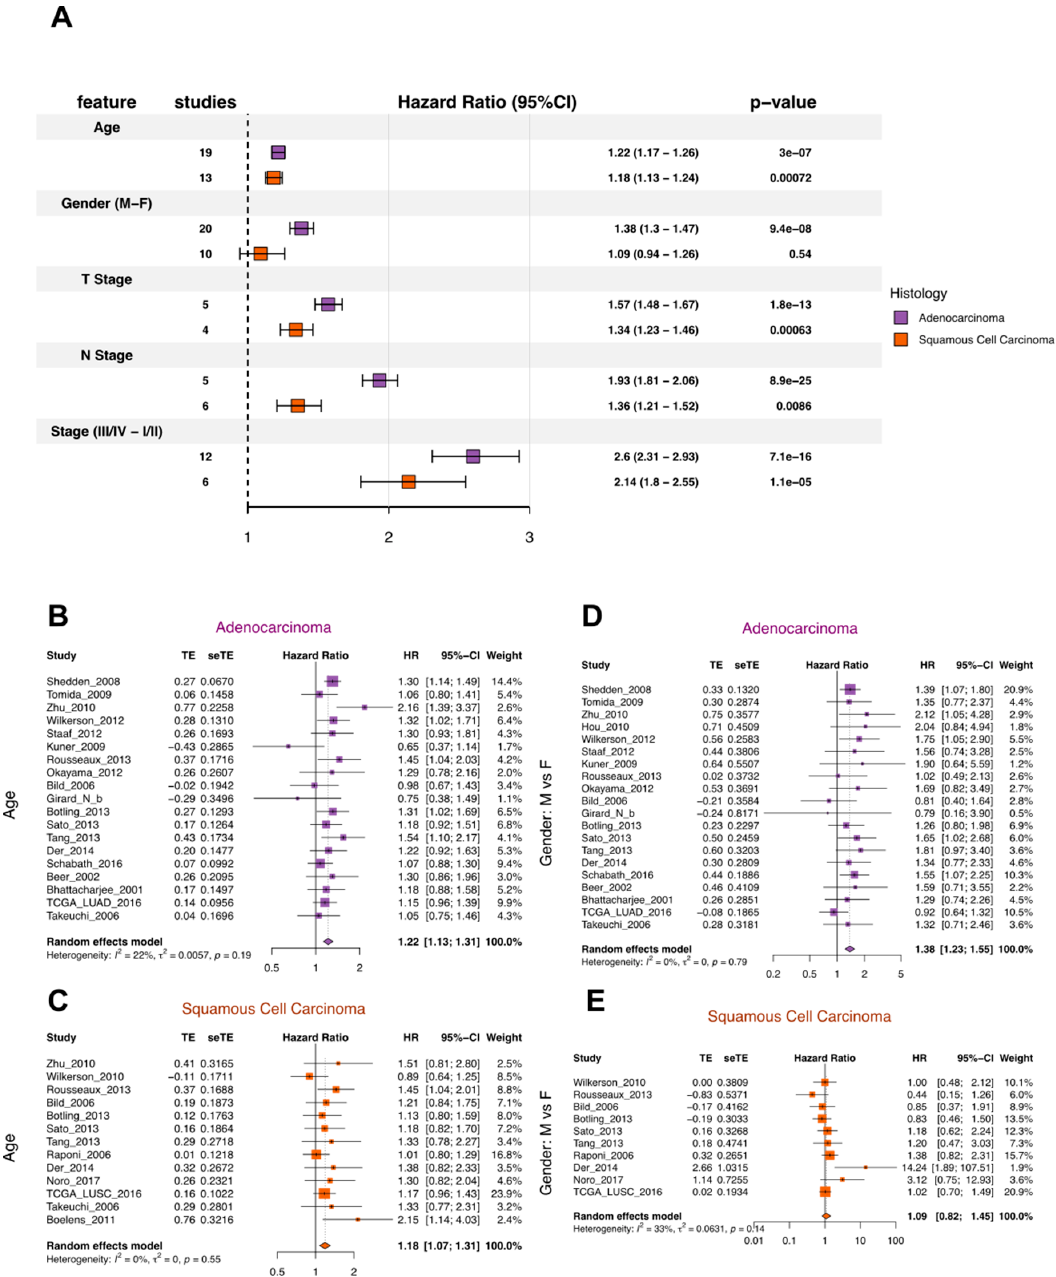
Figure 1. Meta-analysis of survival association for demographics and tumor stages. ( A ) Summary statistics from the meta-analysis of univariate survival association by the Cox-PH model for demographic and tumor stage variables in Adenocarcinoma (ADC) and squamous cell carcinoma (SQCC). ( B , C ) Forest plots showing the meta-analysis results of the survival association for age (10 years is used as 1 unit for age). Increased age was associated with worse survival in both ADC ( B ) and SQCC ( C ). ( D , E ) Forest plots showing the meta-analysis results of the survival association for gender. Male gender was significantly associated with worse survival in ADC ( D ) but not SQCC ( E ).